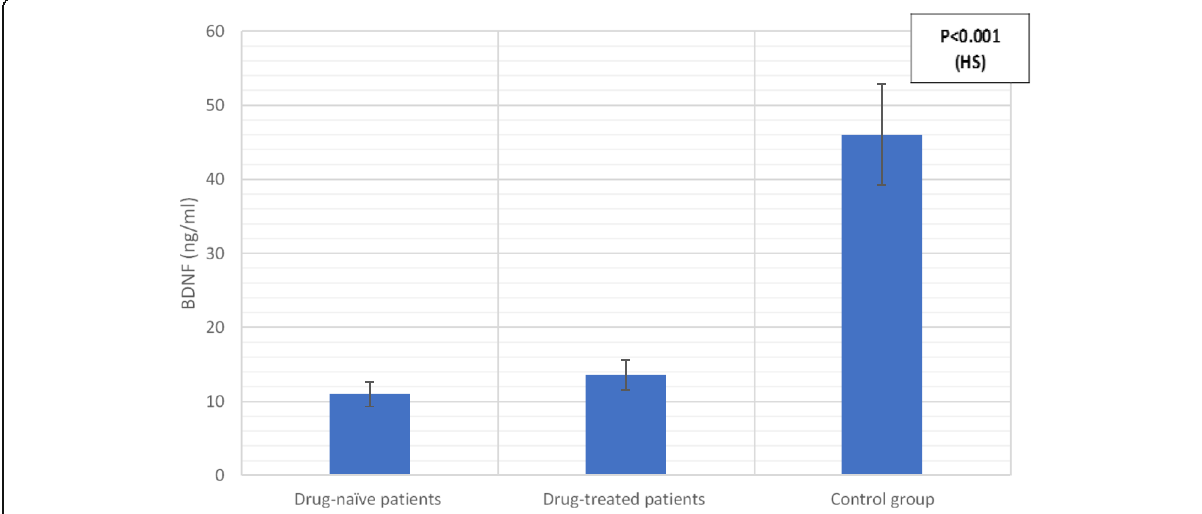
Fig. 1 Serum level of brain-derived neurotrophic factor (BDNF) in the studied groups. HS highly significant